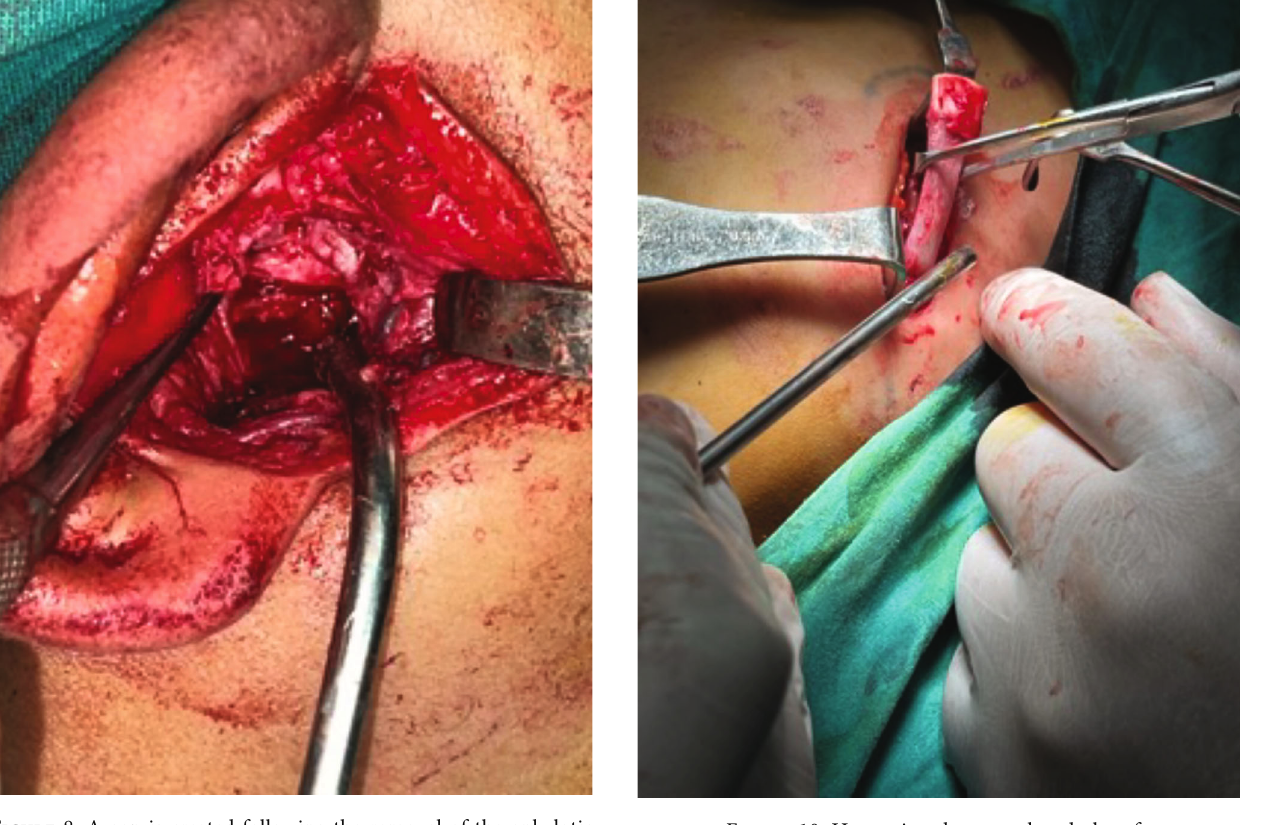
Figure 10: Harvesting the costochondral